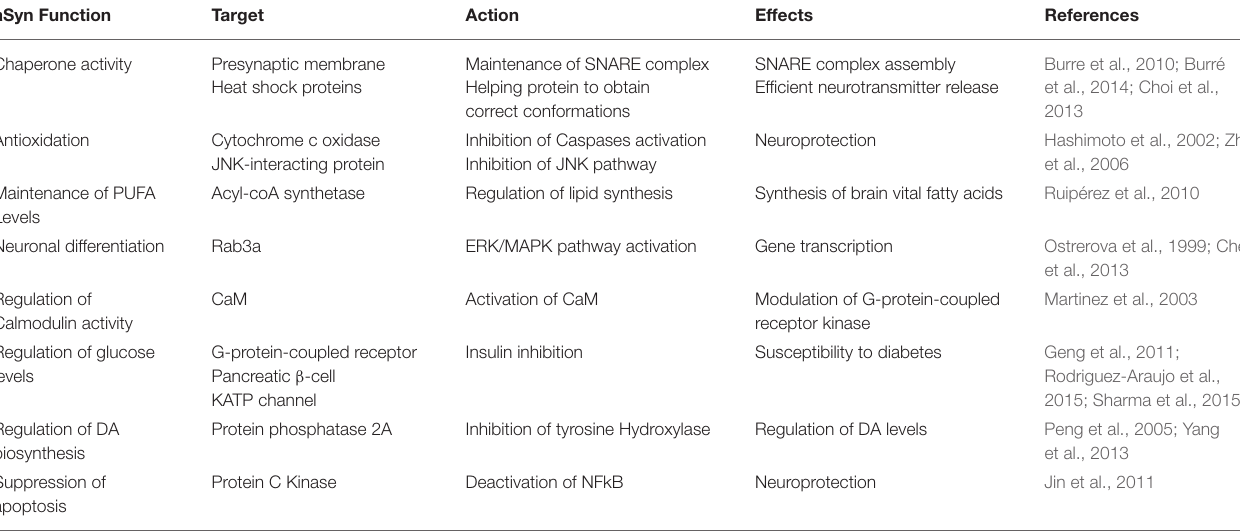
TABLE 1 | Summary of aSyn function, targets, action, and